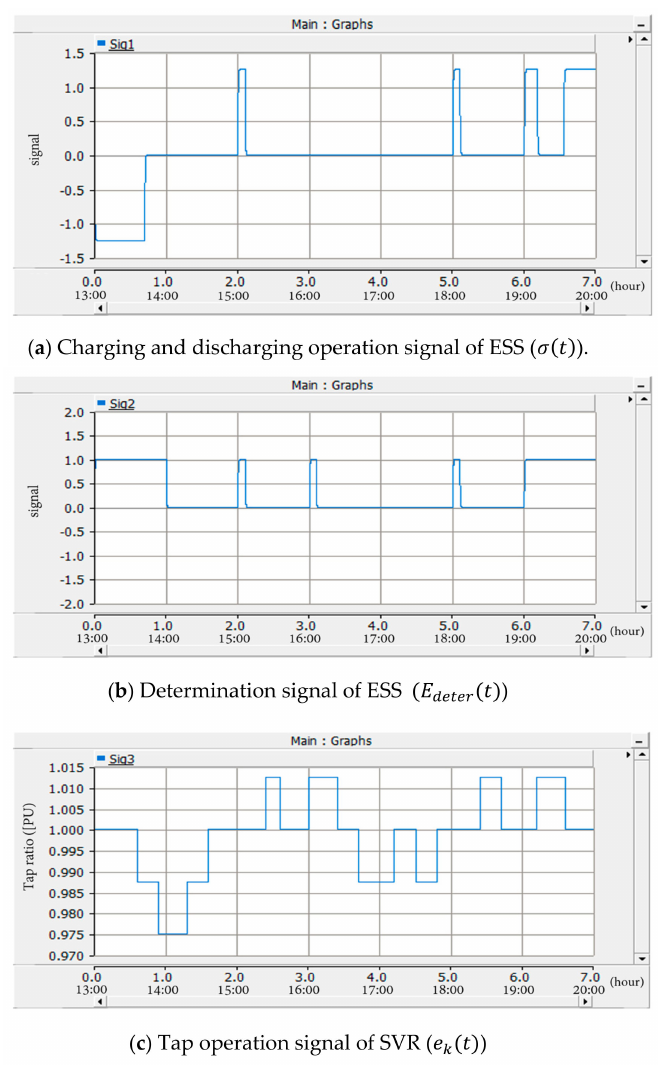
Figure 16. Operation characteristic by the control modeling of